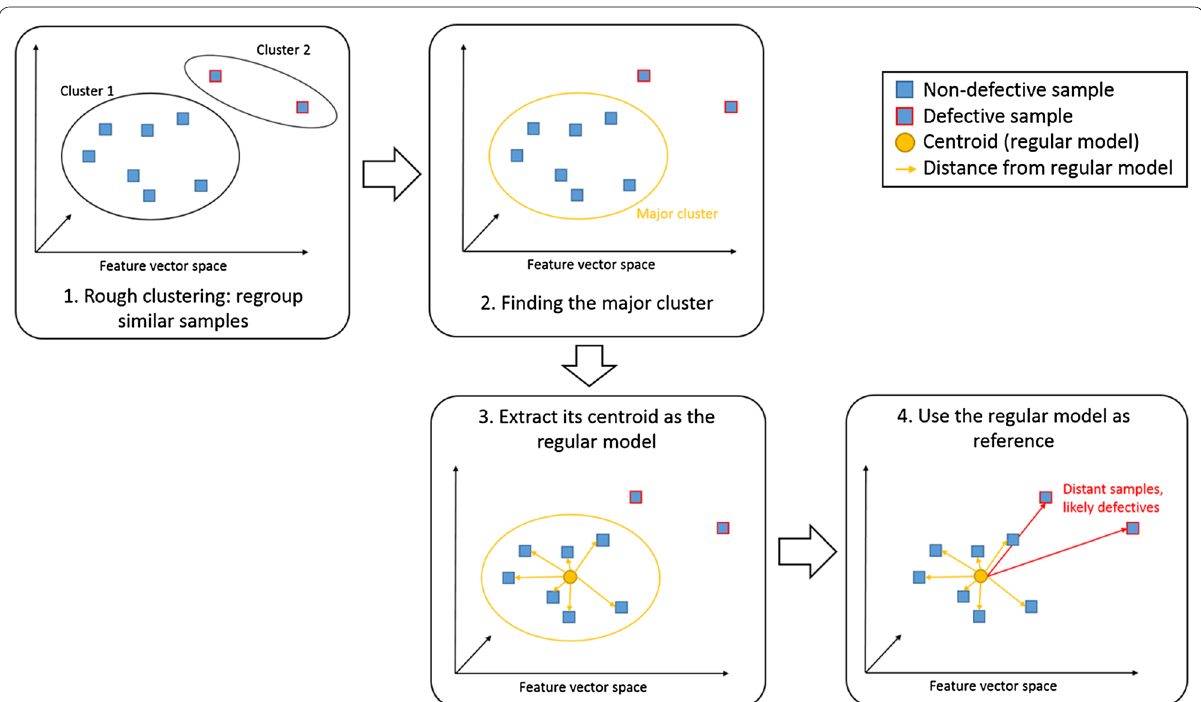
Fig. 2 Main steps of our proposed method given a dataset of samples: 1 roughly cluster in order to swiftly make groups of similar sound samples. 2 Find the major cluster i.e. the cluster best representative of the tested structure. 3 Extract the regular model from this cluster, in this case, the cen- troid. 4 Use the previously found regular model as a scale, reference for the non-defective sample to conduct diagnosis on the whole